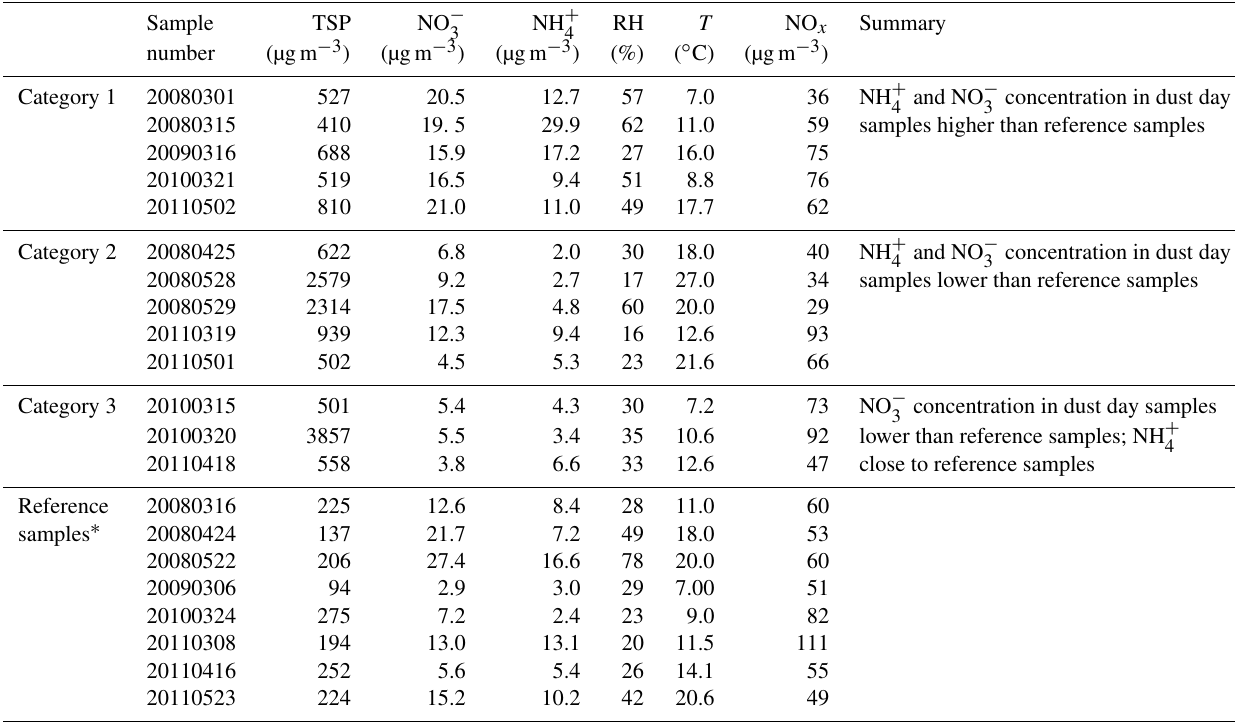
Table 4. Average measured concentrations of NH + category in